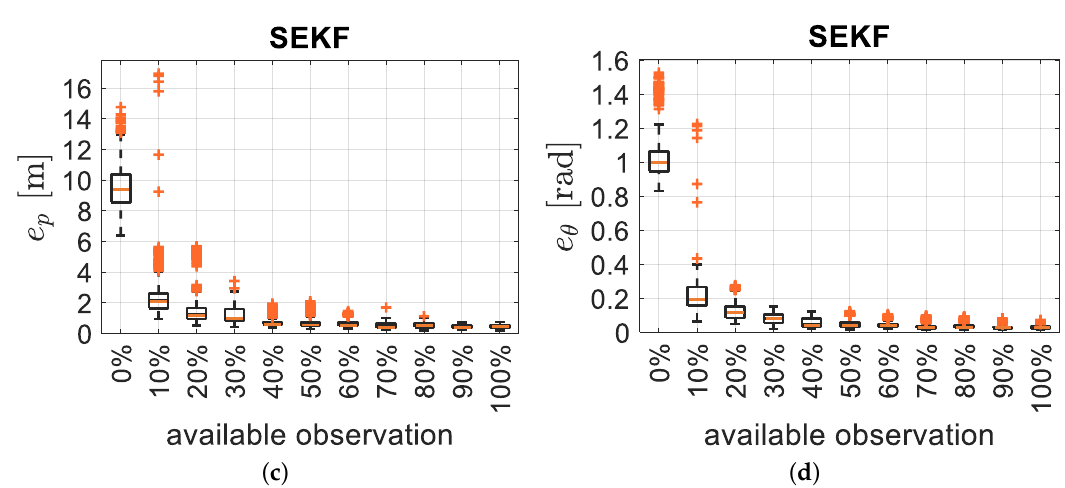
Figure 9. ( a , c ) Position and ( b , d ) orientation RMSE for different percentages of available observations for the EKF ( a , b ) and the SEKF ( c , d ).